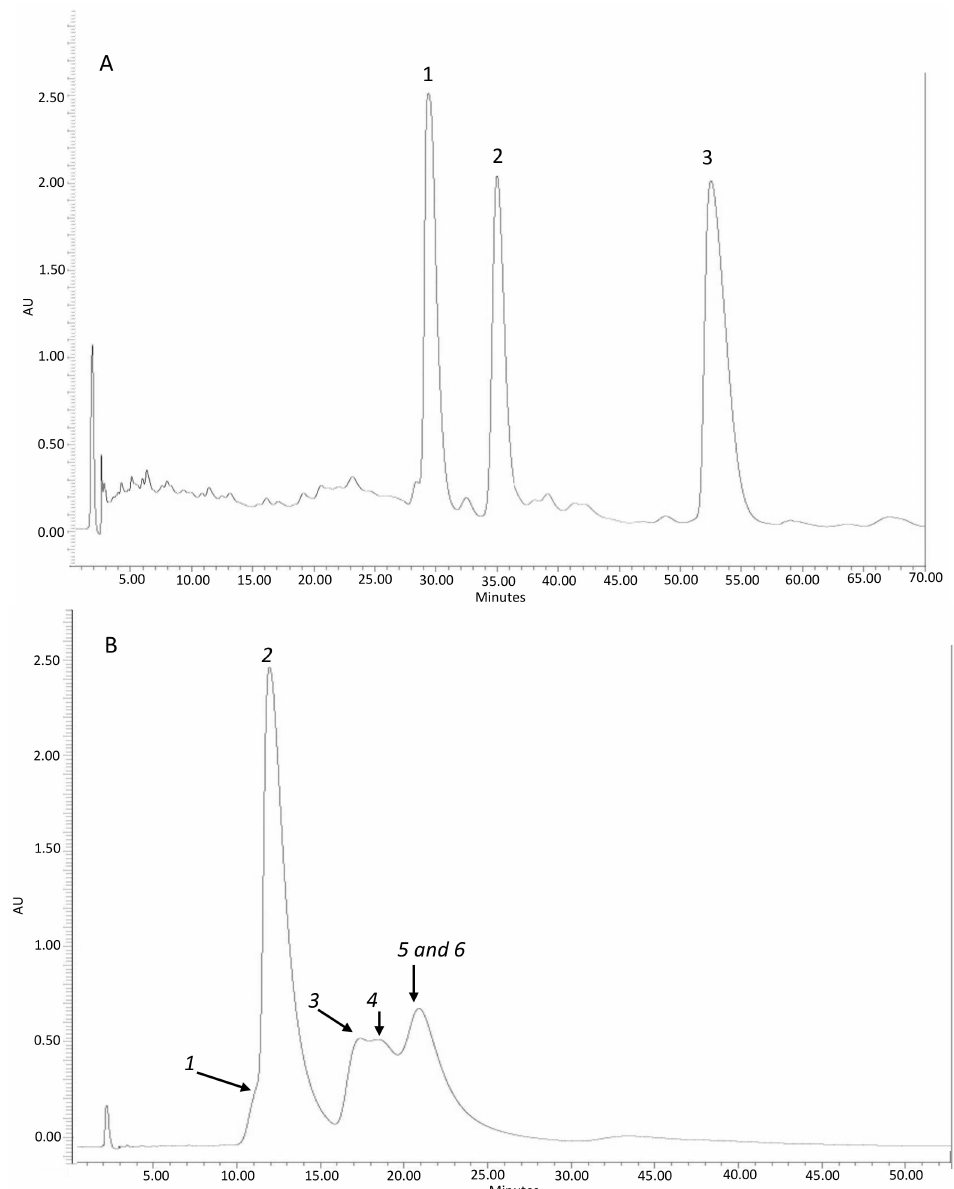
Figure 4. Representative HPLC-UV (diode array detector(DAD)) chromatogram of: Fraction 1 ( A ) withthepresenceofditerpenes: 1 :oxocativicacid, 2 :7-oxo-8-labden-15-oicacid, 3 :-acetoxi-7-oxo-8-labden-15-oic acid; Fraction 2 ( B ) with the presence of flavonoids: 1 : Apigenin, 2 : 3-Omethylkaempherol, 3 : 4 (cid:48) -O-methylapigenin, 4 : 7-O-methylapigenin; 5 : 3,7